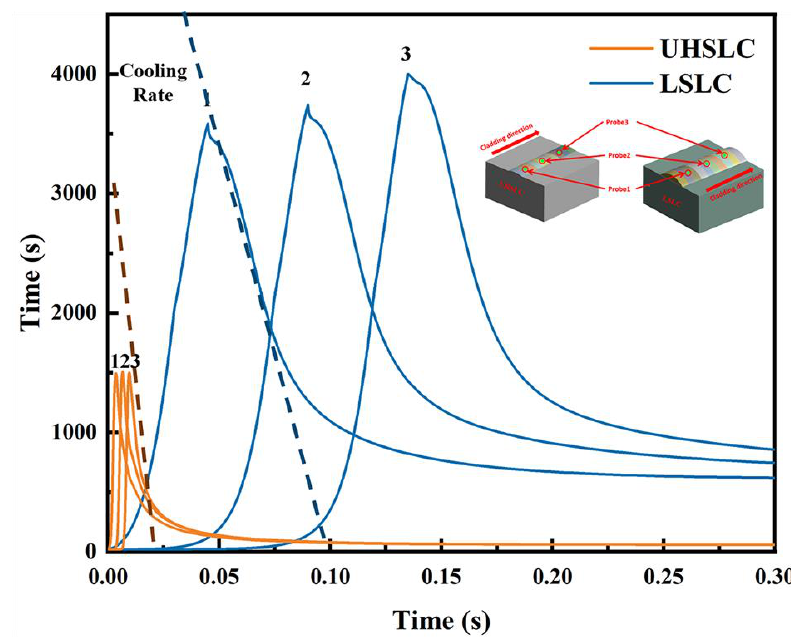
Figure 16. Temperature distribution of UHSLC and LSLC at different points.